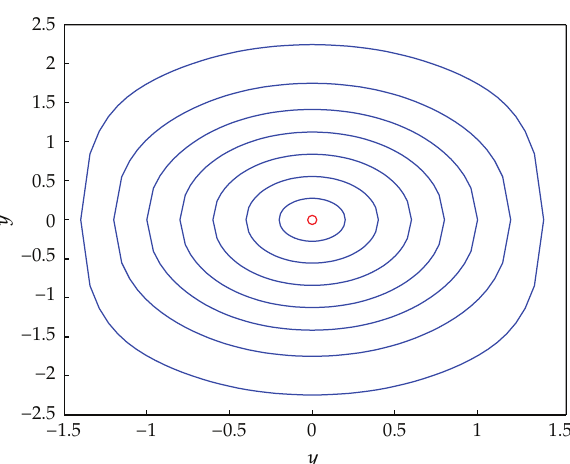
Figure 3: Phase portrait of critical equation (cid:2) 4.16 (cid:5) , where s α (cid:6) − 1 and (cid:7) α ≥